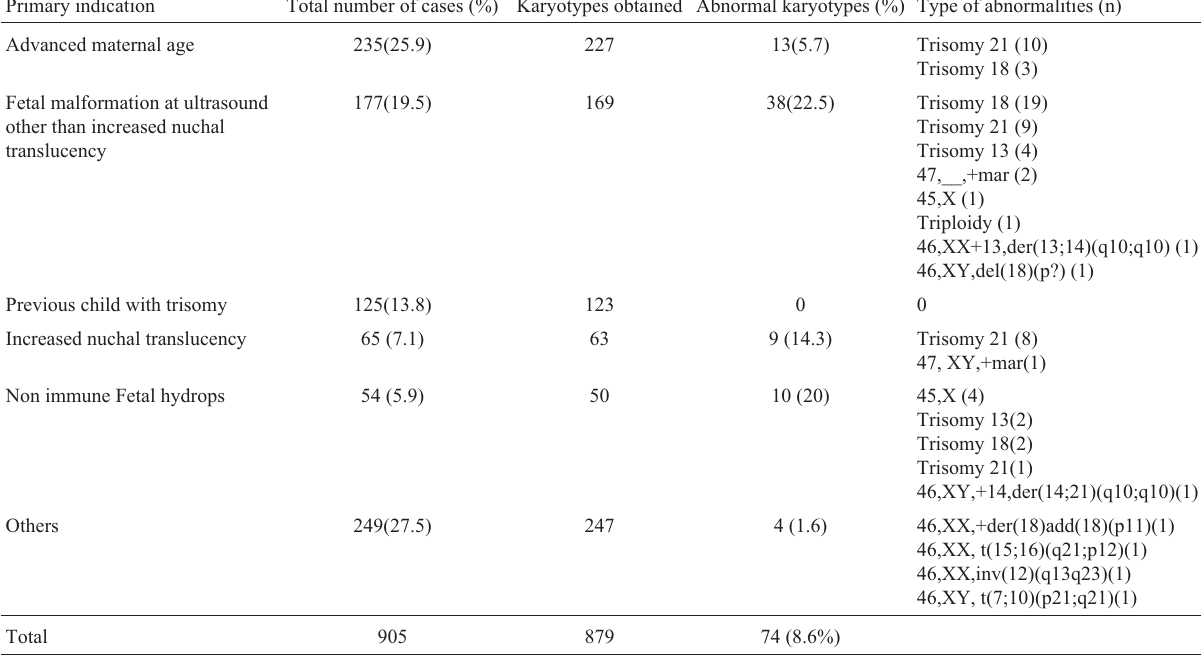
Table 1 - Indications for invasive prenatal diagnosis and abnormal karyotypes. Primary